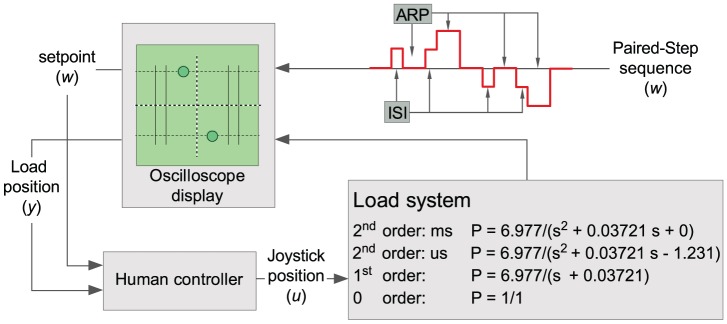
Diagram of the control system and the experimental set up.The system is ‘virtual’ and is controlled through a joystick interface. The participant receives visual feed-back information about the system position through a dot presented on a real oscilloscope. The joystick position defined the system's: position (0 order system), its velocity (1st order system), or its acceleration (2nd order system). While controlling the system, participants were asked to track the position of a second dot displayed on the oscilloscope. The four possible step sequences (uni- and reversed directional step to the left or to the right) of the pursuit target are illustrated by the red line. First and second stimuli are separated by an inter-step interval (ISI), double stimuli are separated by an approximate recovery period (ARP). When applied to a model (as shown in Fig. 7), this sequence is applied as a set-point disturbance.